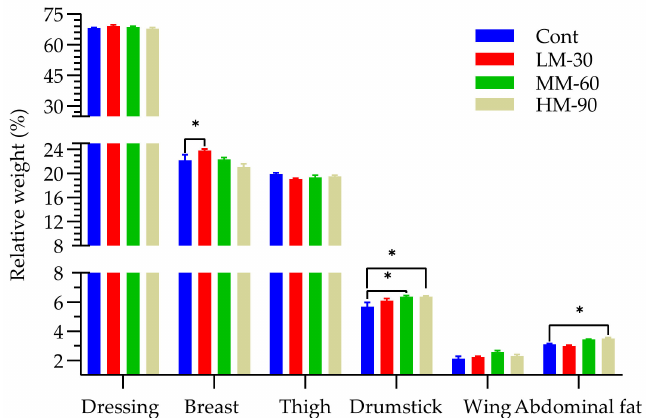
Figure 2. Effect of β -mannanase supplementation on dressing percentage and carcass parts in broilers fed low energy diets. Dressing is dressing percentage, while parts are expressed as a percentage of carcass weight. Cont (ME 3100 kcal/kg): without β -mannanase; LM-30 (ME − 30 kcal/kg), MM-60 (ME − 60 kcal/kg), and HM-90 (ME − 90 kcal/kg) were supplemented with 200, 400, and 600 mg/kg β -mannanase, respectively. Statistical difference from corresponding control value for a given parameter is marked with *: p <